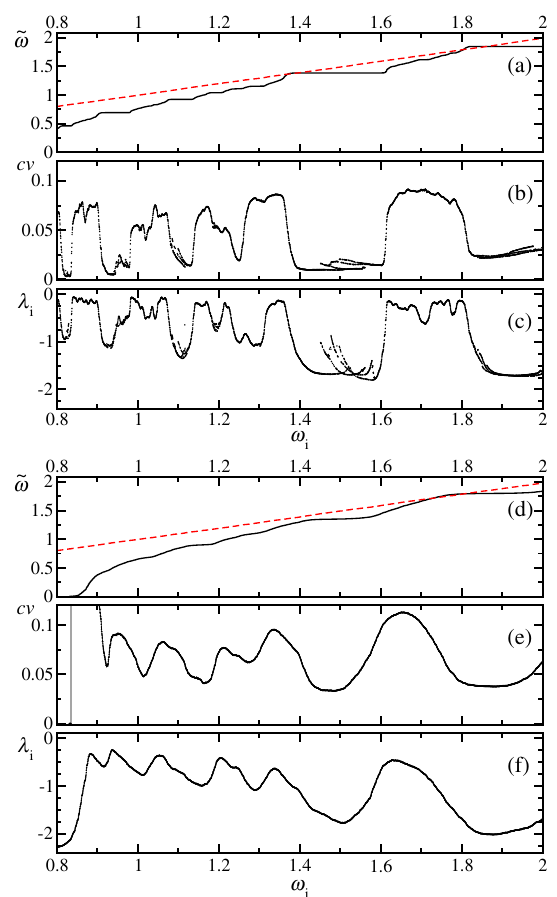
FIG. 9. Effective frequency ~ ω [panels (a) and (d)], CV of ~ ω [panels (b) and (e)], and conditional Lyapunov exponents λ [panels (c) and (f)] for the different oscillators, for g ¼ 1 [panels (a) – (c)] and g ¼ 1 . 3 [panels (d) – (f)], all for N ¼ 4000 . The red dashed line in panels (a) and (d) show the bare frequency as a reference for the effective frequency shown with solid black